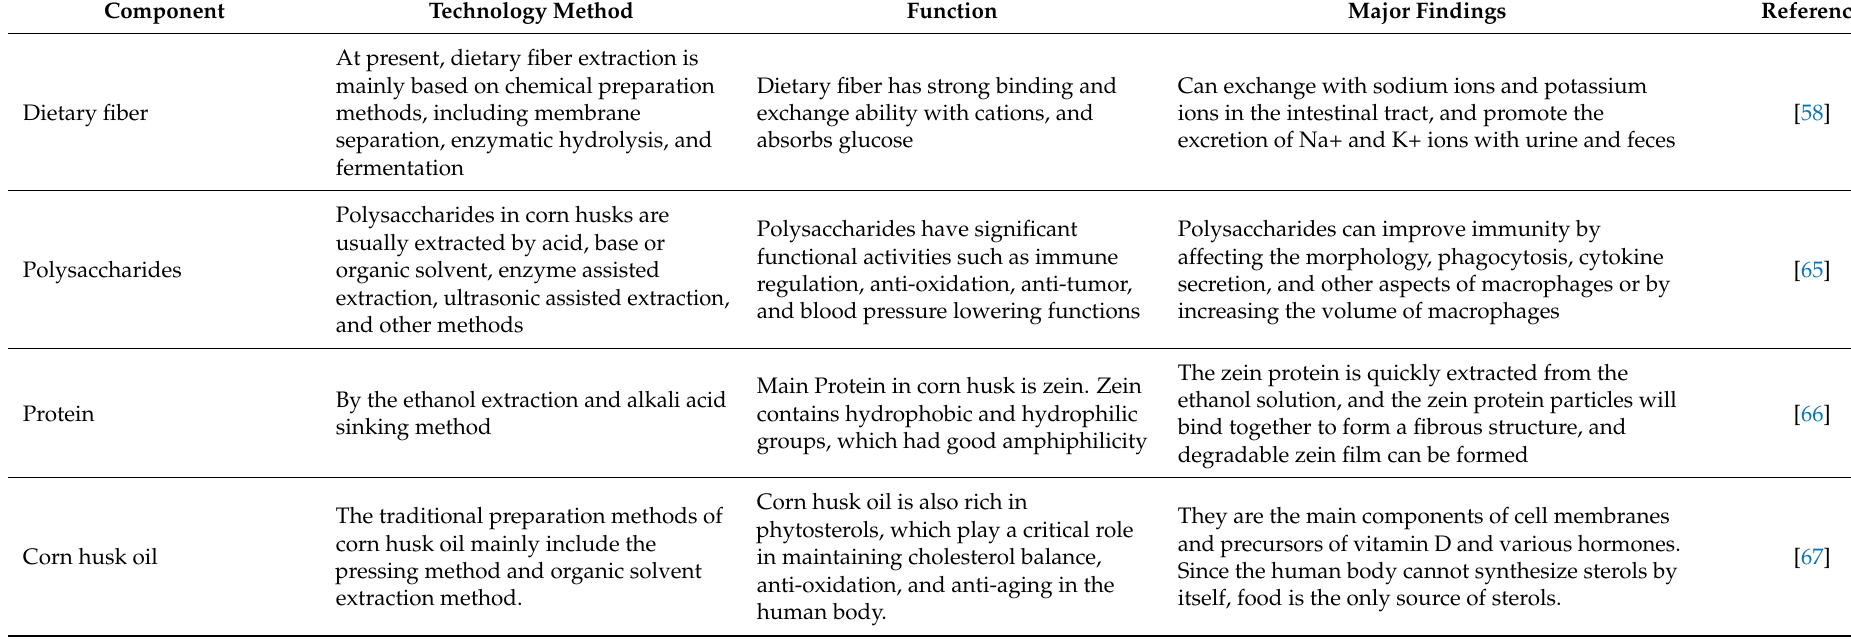
Table 2. The main component, technology method, function, and major findings of corn